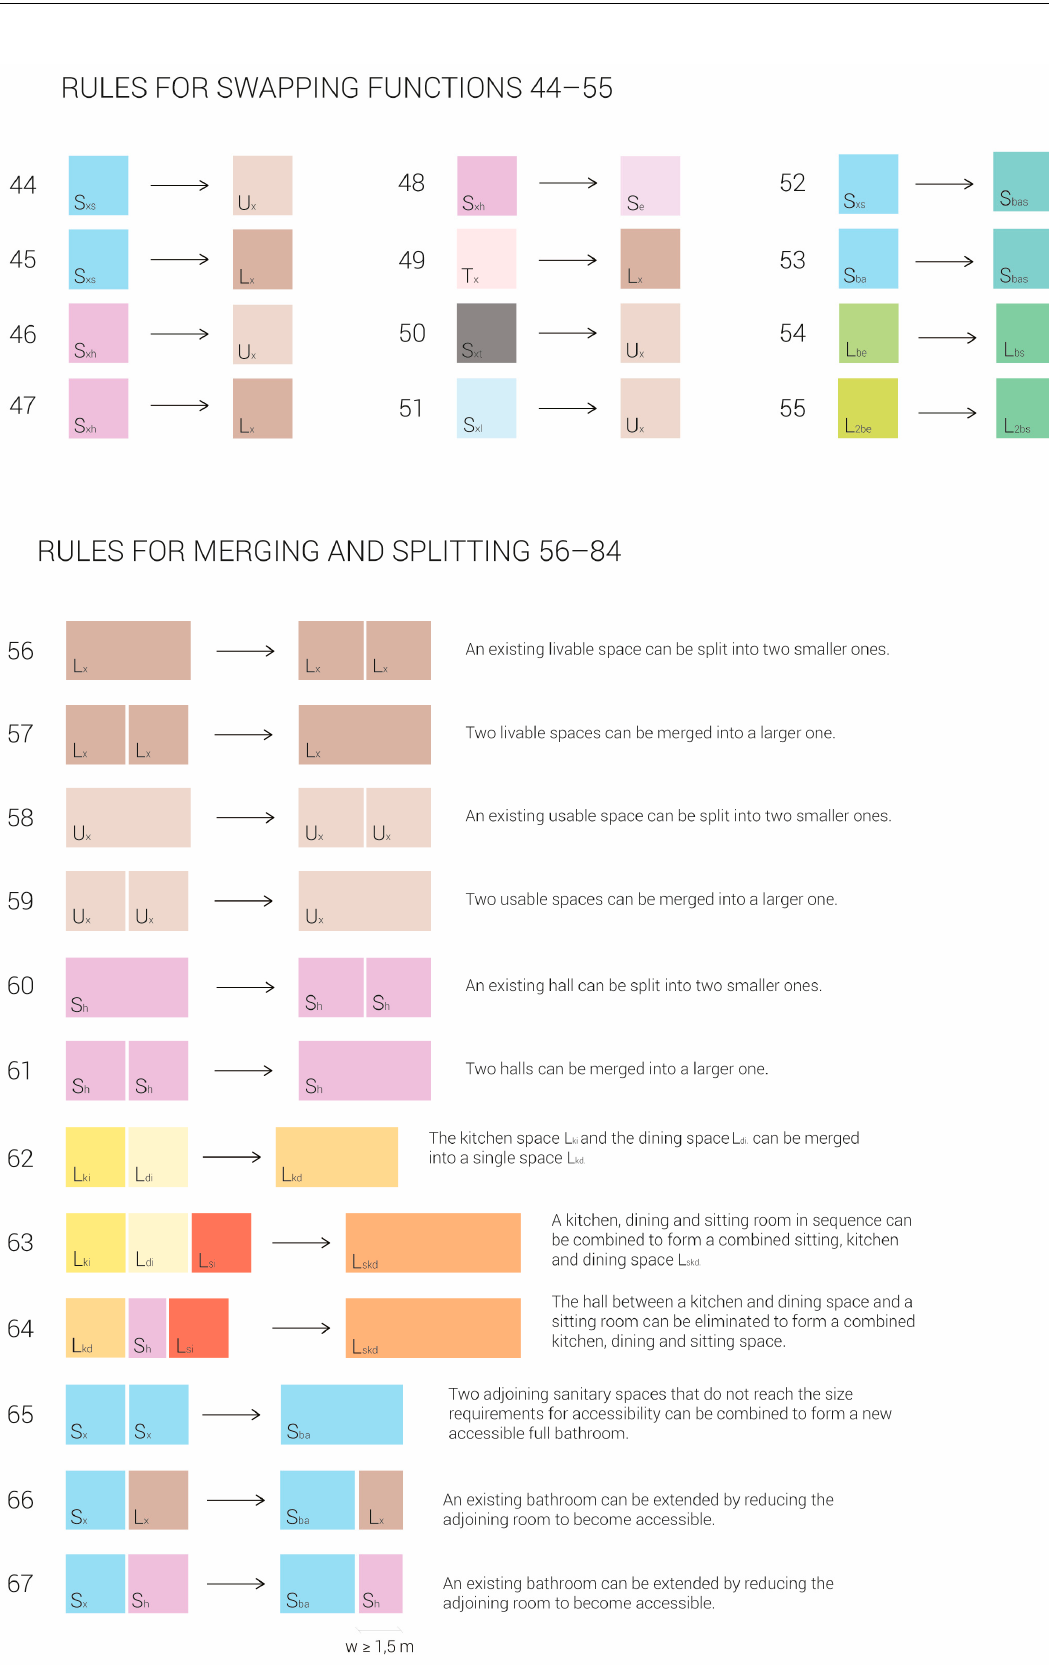
Figure 12. Transformation rules 44–67 (Ana Bel č i č , 2022).